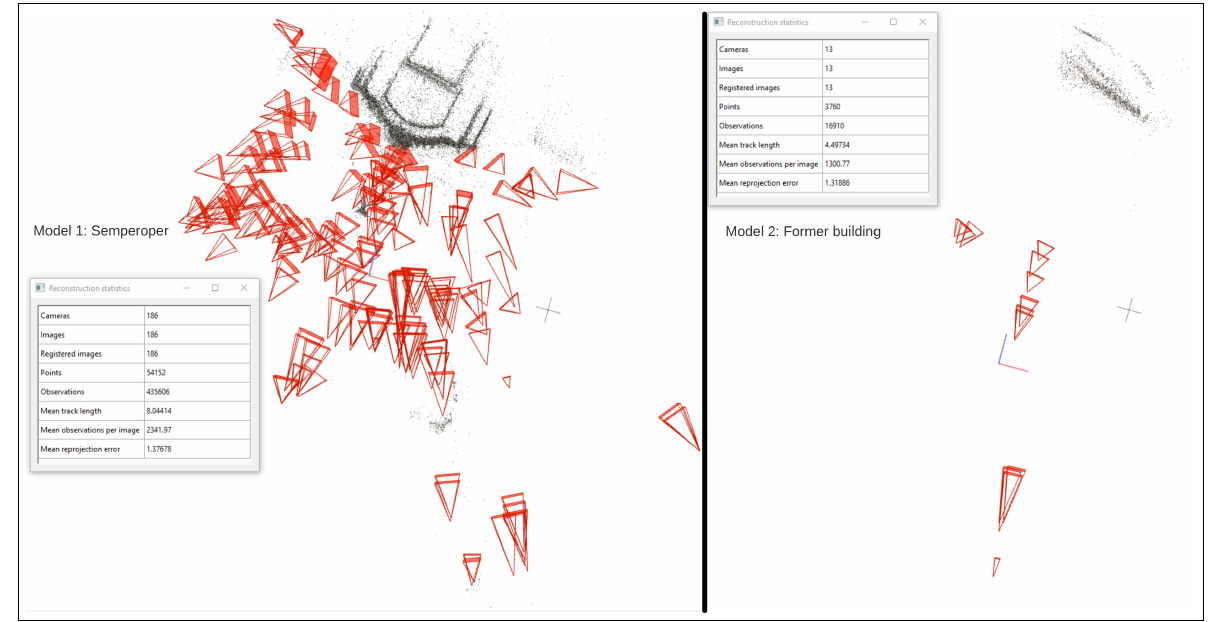
Figure 12. ( Left ): Correct COLMAP reconstruction of all Semperoper images retrieved by LEA with an increased number of minimum matches between image pairs. ( Right ): Reconstruction of the former opera house of 1869 automatically created in the bundle adjustment in COLMAP.